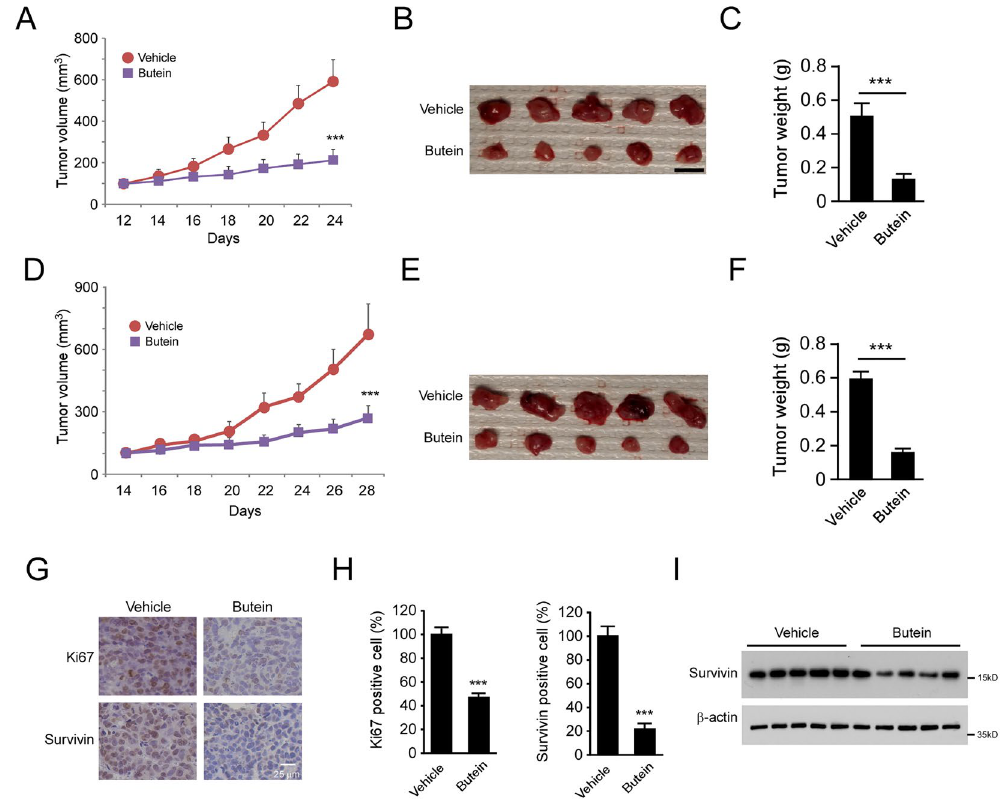
Figure 6. Butein suppresses the in vivo tumor growth. ( A – C ) The tumor volume ( A ), The image of tumor mass ( B ), and tumor weight ( C ) of CNE2-derived xenograft tumors treated with vehicle control or Butein. *** p < 0.001. ( D – F ) The tumor volume ( D ), The image of tumor mass ( E ), and tumor weight ( F ) of HONE1- derived xenograft tumors treated with Vehicle control or Butein. *** p < 0.001. ( G and H ) IHC staining ( G ) and quantitative analysis ( H ) of Ki67 and survivin expression in CNE2-derived xenograft tumors with vehicle or Butein treatment. *** p < 0.001. Scale bar, 25 μm. ( I ) IB analysis of survivin expression in CNE2-derived xenograft tumors with Vehicle or Butein